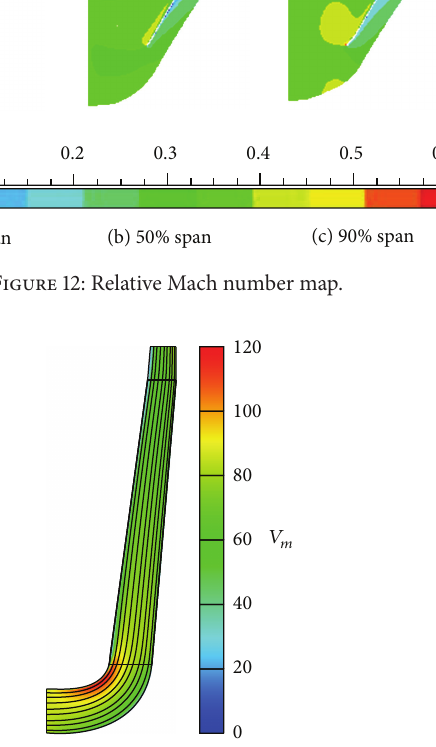
Figure 13: Meridional velocity and streamline distribution.